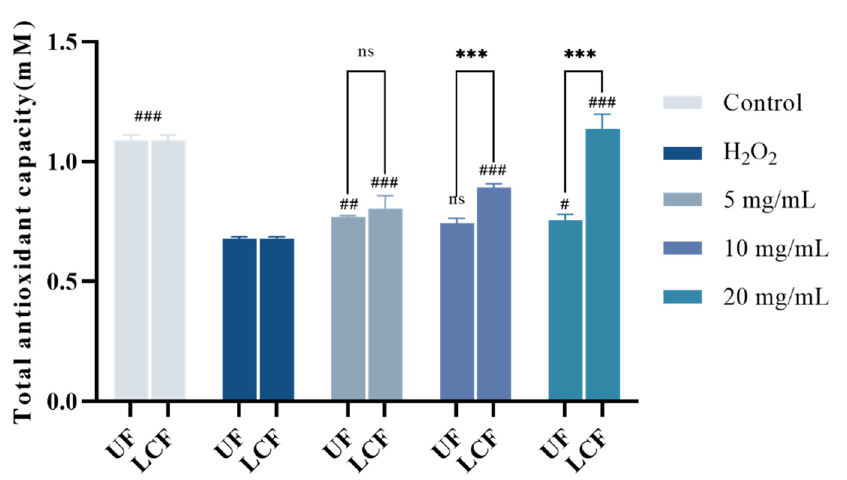
Figure 7. Effects of UF and LCF on cellular antioxidant capacity. UF: unfermentation; LCF: single microbial fermentation with L. curvatus . Analysis of significant differences between each group and H 2 O 2 model group, #: p < 0.05; ##: p < 0.01; ###: p < 0.001. comparison of each group between UF and LCF, ***: p < 0.001; ns: p > 0.05.